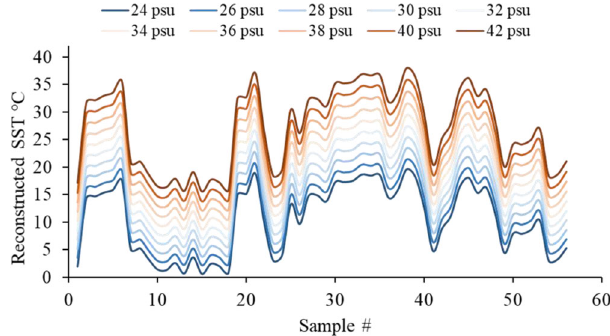
Fig. 4 Climate Reconstruction from historical shell specimen.